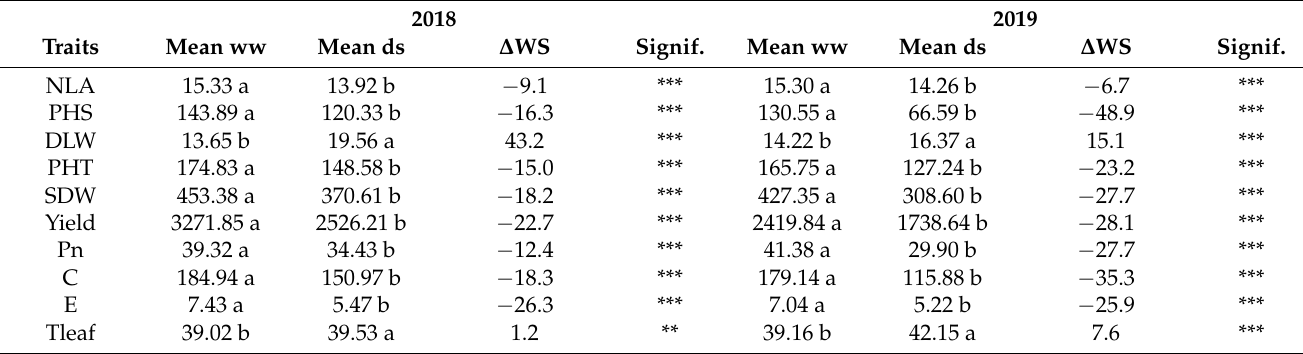
Table 2. Average performance and statistical parameters of some agro physio and morphological traits of sorghum genotypes under well-watered and drought stress conditions of 2018 and 2019 field trials. 2018 2019 Traits Mean ww Mean ds ∆ WS Signif. Mean ww ∆ WS Signif.